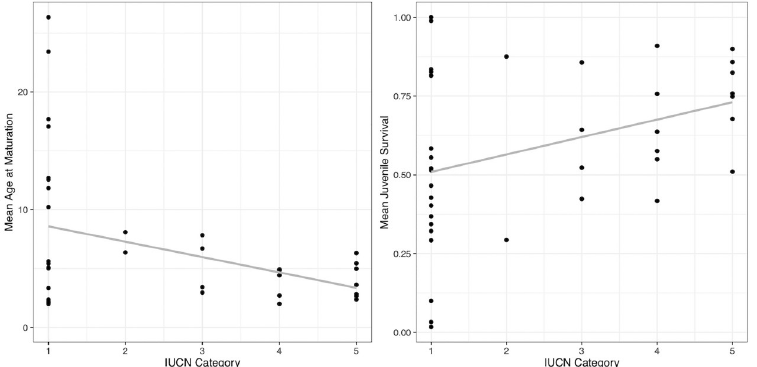
Fig 1. Relationship between endangered status and the most important predictors for herbaceous perennials. The most important predictors of endangered status for 39 herbaceous perennial species are mean age at maturation (left panel) and mean juvenile survival rate (right panel). Trendlines are based on a linear regression of the raw data points and show mean age at maturation decreases with risk, while mean juvenile survival increases with extinction risk. IUCN Red List category (1: Least Concern, 2: Near threatened, 3: Vulnerable, 4: Endangered, 5: Critically Endangered) is used as a proxy of extinction risk.